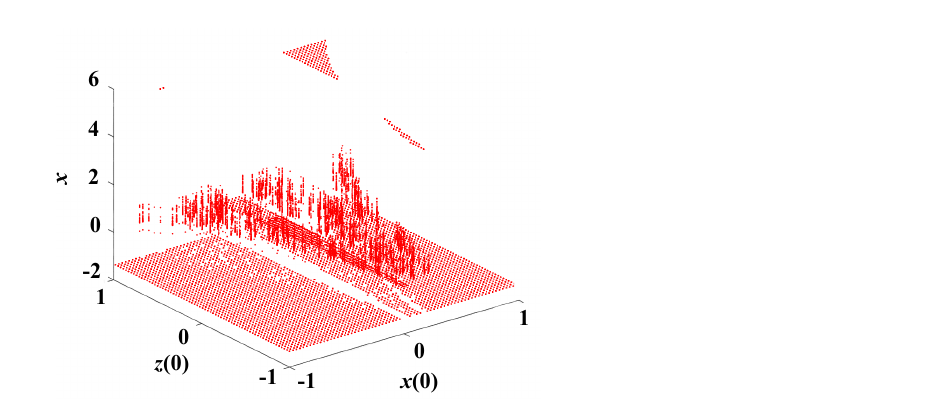
Figure 14. The three ‐ dimensional bifurcation diagram of the HNN varying with x (0) and z (0). Observe from Figure 14 that the chaotic and periodic orbits switch with each other over the range of x (0) ∈ [–1,1] and z (0) ∈ [–1,1], indicating that rich and complex dynam ‐ ics emerge in the HNN.